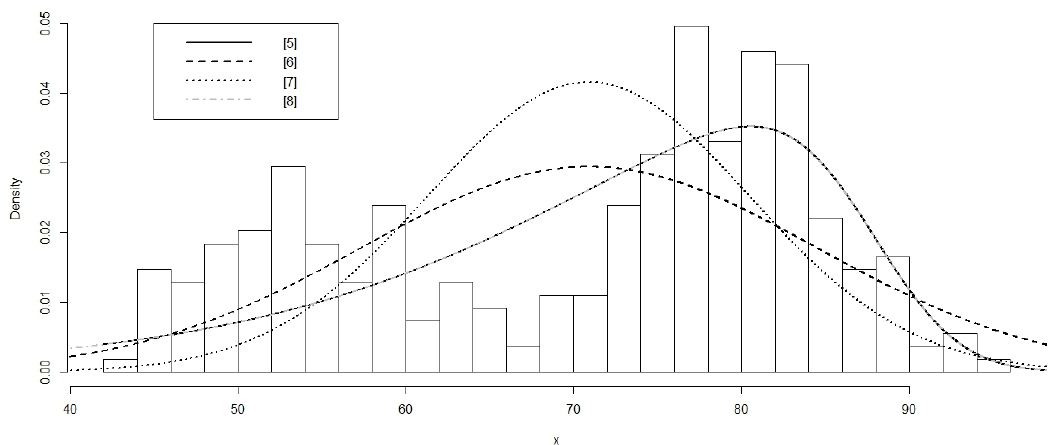
Figure 10. Faithful data - Fitted Nadarajah and Kotz [6] distributions. [5] Skew Logistic-Normal distribution; [6] Skew Logistic- t distribution; [7] Skew Normal-Logistic distribution; [8] Skew t -Logistic distribution.